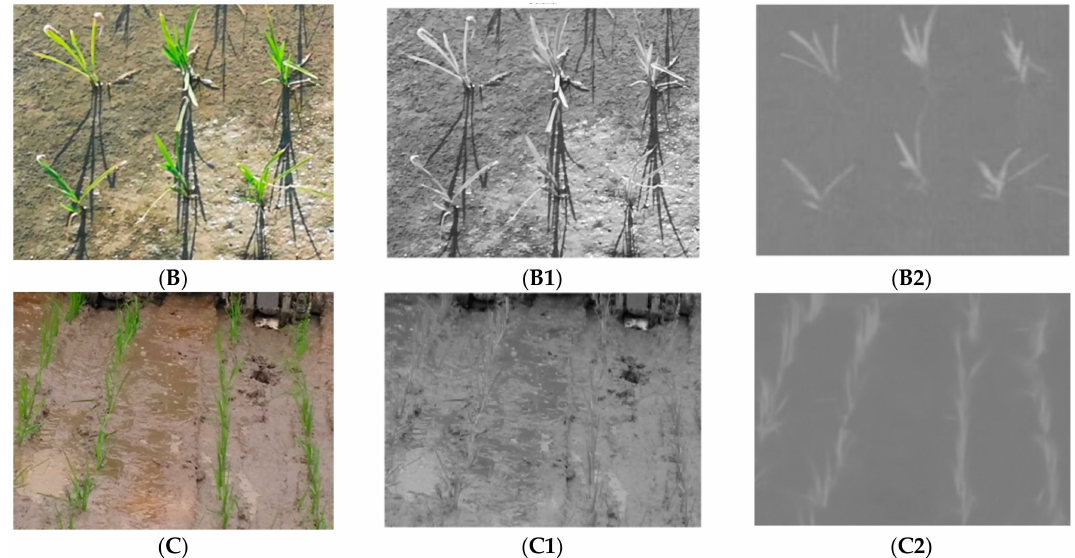
Figure 2. The typical rice seedling images in paddy fields and conversion results in different color spaces. ( A ) the original rice seedling image with highlight on a sunny day; ( A1 , A2 ) correspond to images of G and Cg; ( B ) the original seedling image with shadow on a sunny day; ( B1 , B2 ) correspond to images of G and Cg; ( C ) the original seedling image with much mud on a cloudy day; ( C1 , C2 ) correspond to images of G and